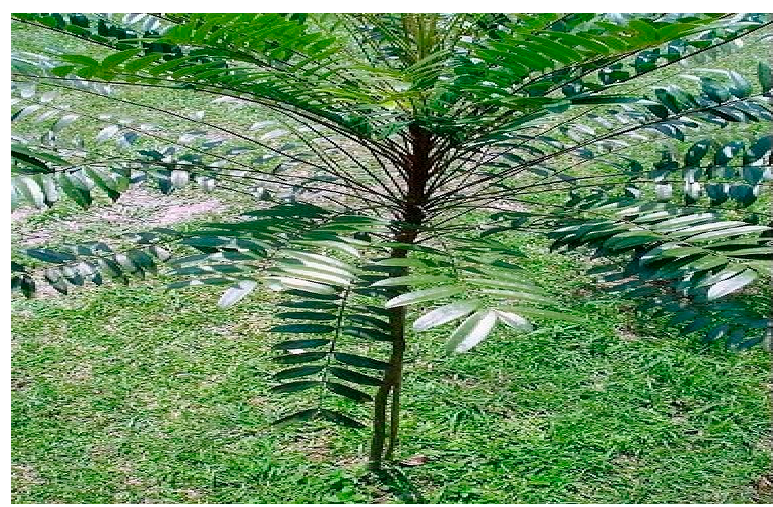
Figure 3. Image of Eurycoma longifolia jack plant. Source: [93].